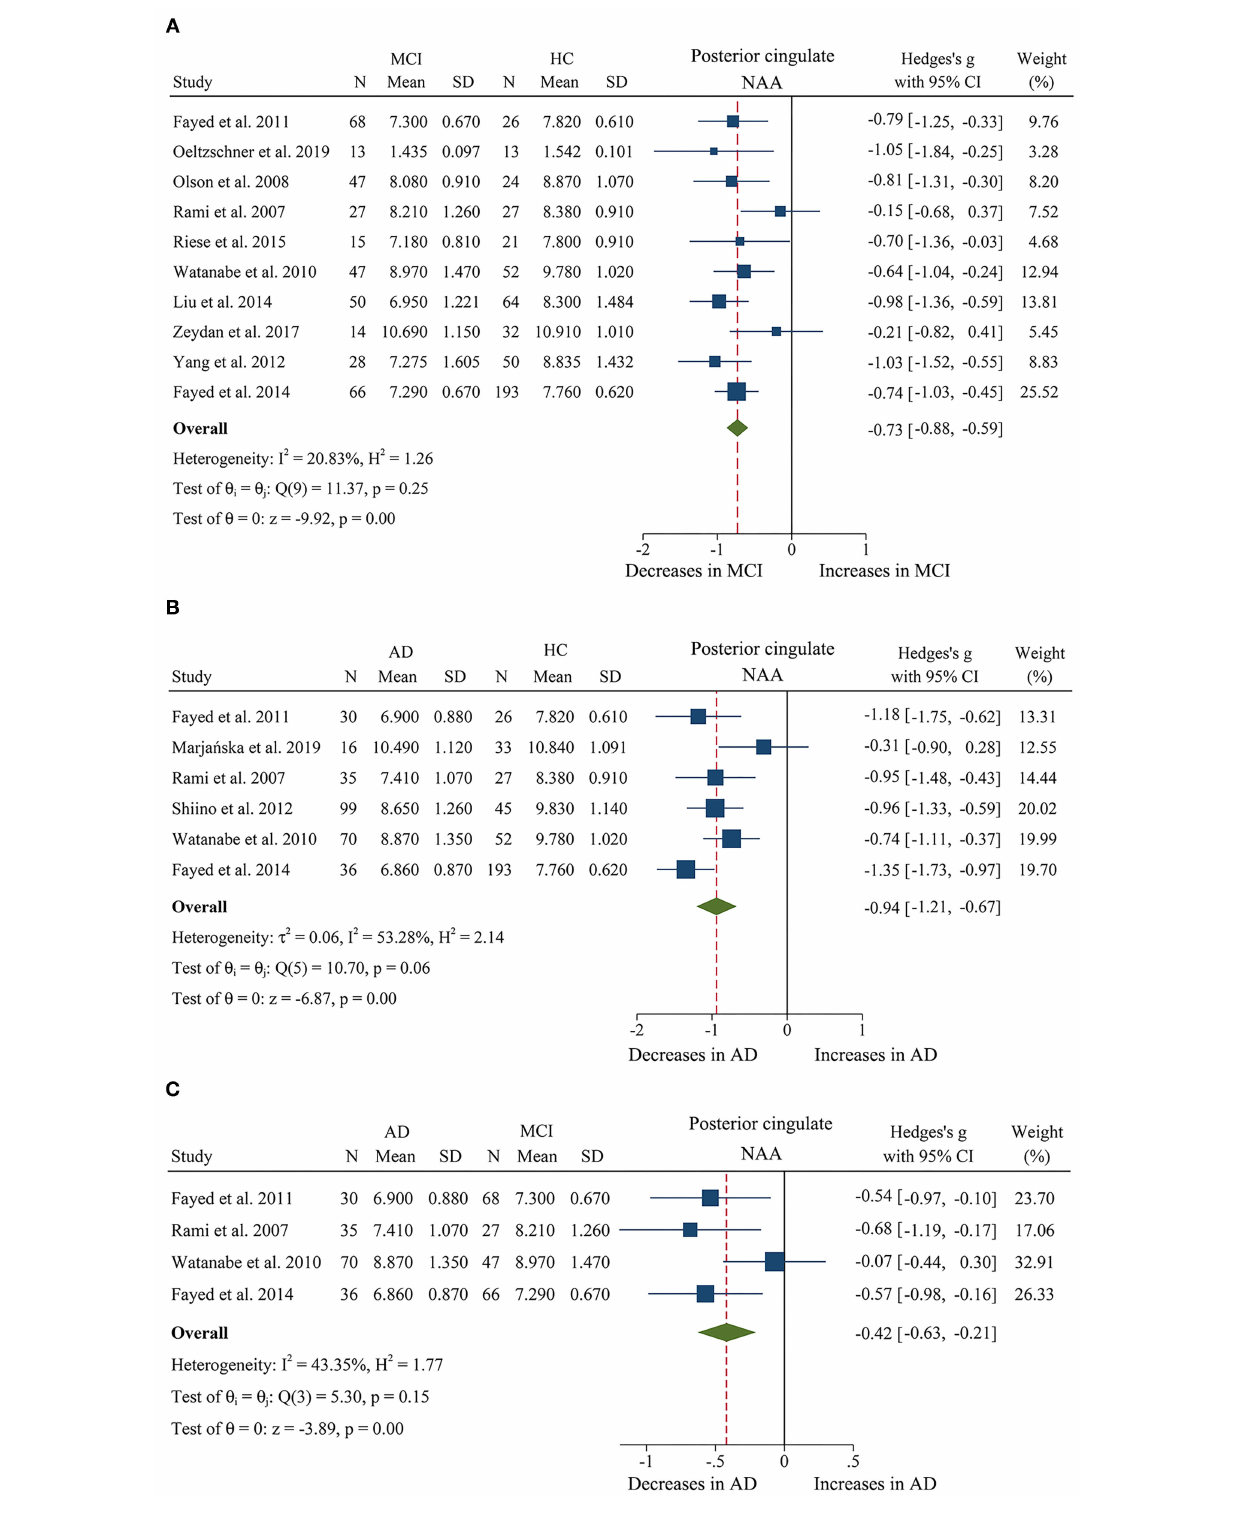
Frontiers in Aging Neuroscience |